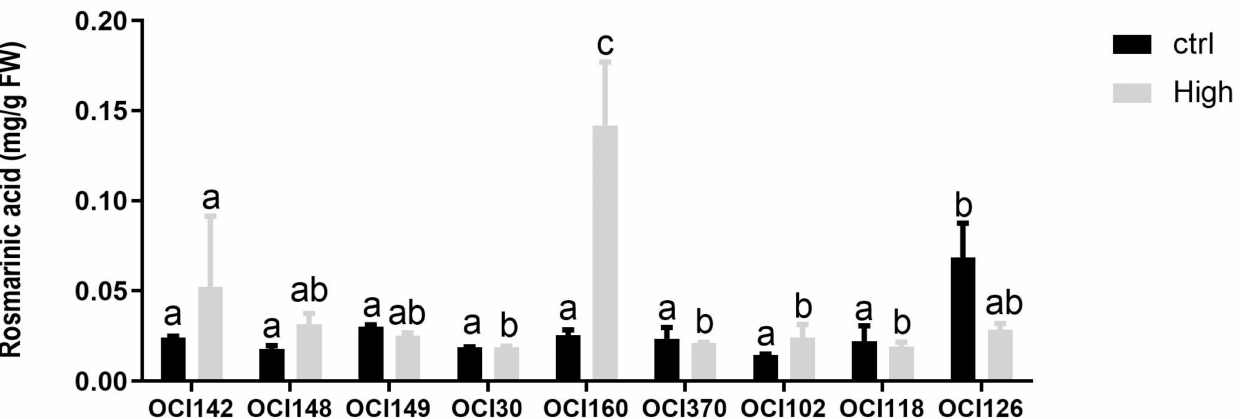
Figure 4. Time course of changes in rosmarinic acid content in leaves of nine different sweet basil ecotypes exposed to UV-B light (68 kJ m − 2 day − 1 ) or not exposed (ctrl). Data are shown as mean with at least five independent biological replicates. The measurements were carried out at 48 h from the beginning of the exposure. Data were subjected to analysis of variance and differences between ecotypes were analyzed by Tukey’s multiple comparisons test. Different letters denote significant differences at p <